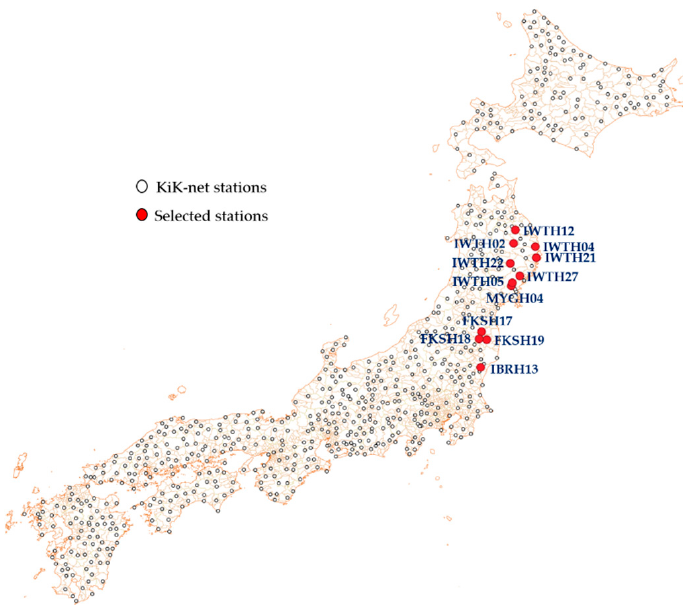
Figure 1. The selected stations.